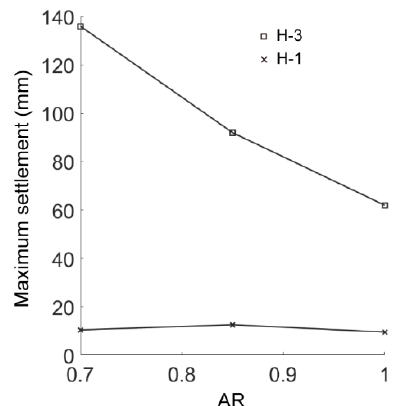
Figure 20. Maximum settlements of measuring lines H-1 and H-3 as a function of AR.